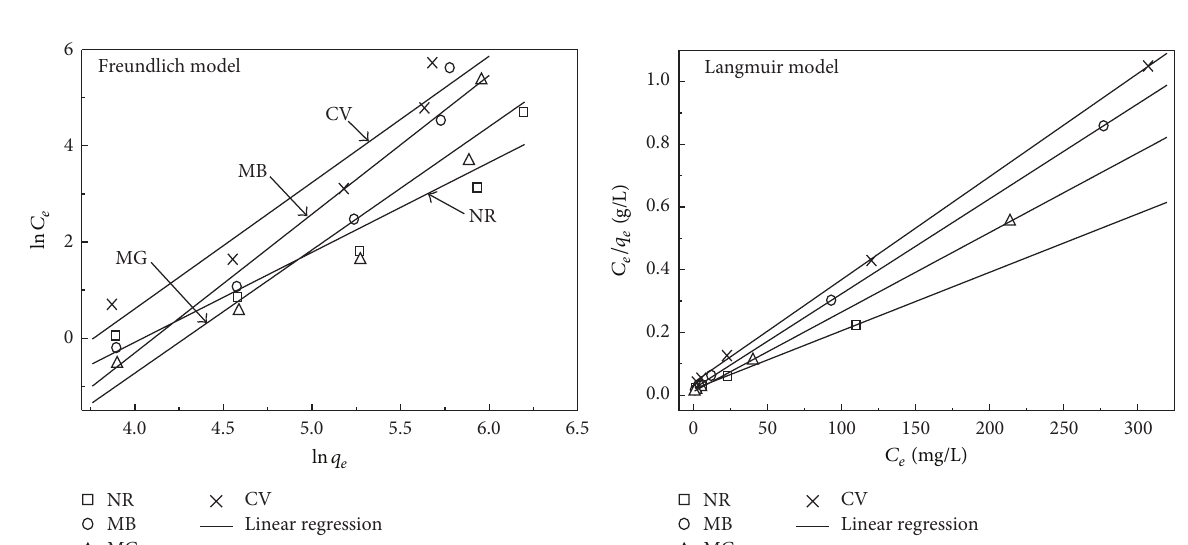
Figure 11: Langmuir and Freundlich sorption isotherms of NR, MB, MG, and CV on